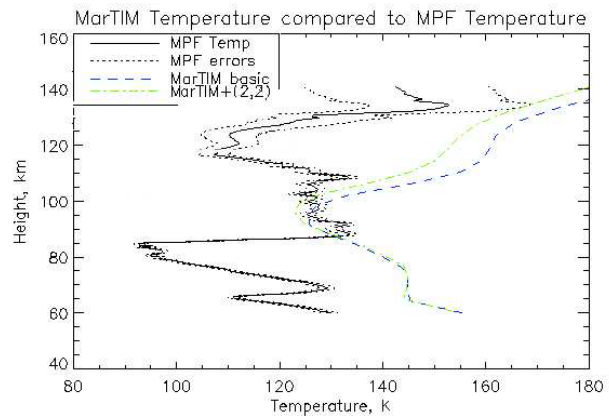
Fig. 15. Mars pathfinder temperature profile compared to basic Fig. 15. Mars path(cid:2)nder temperature pro(cid:2)le compared to basic MarTIM and MarTIM+(2,2) tide temperature profiles for the same MarTIM and MarTIM+(2,2) tide temperature pro(cid:2)les for the same conditions and position. conditions and position.